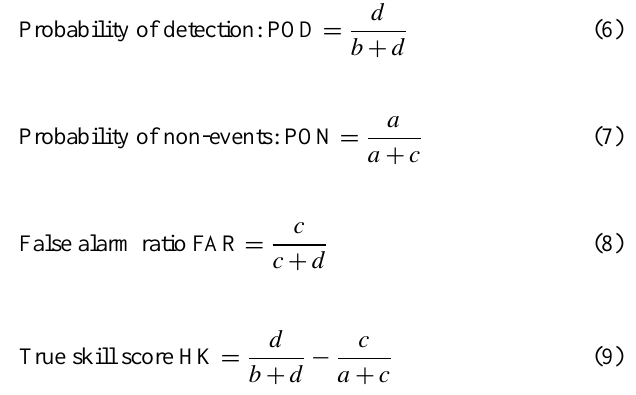
Observed Non-avalanche